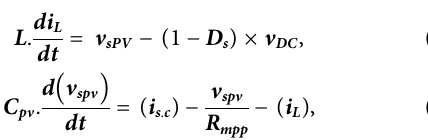
Frontiers in Energy Research |